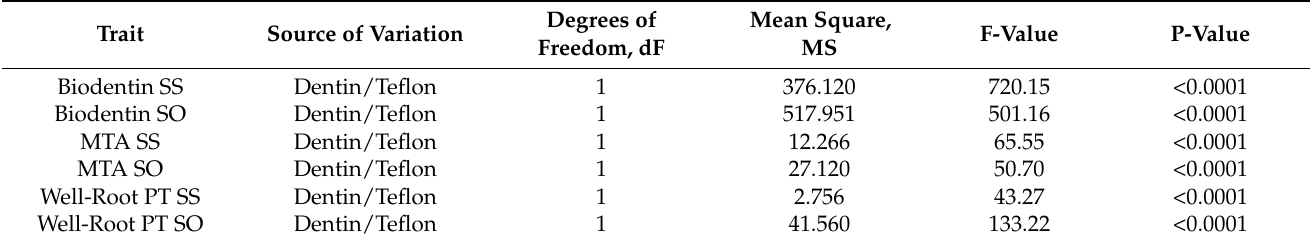
Table 4. ANOVA analysis of differences between two different disc types (dentine and Teflon) for each material group (Biodentin, MTA and Well-Root